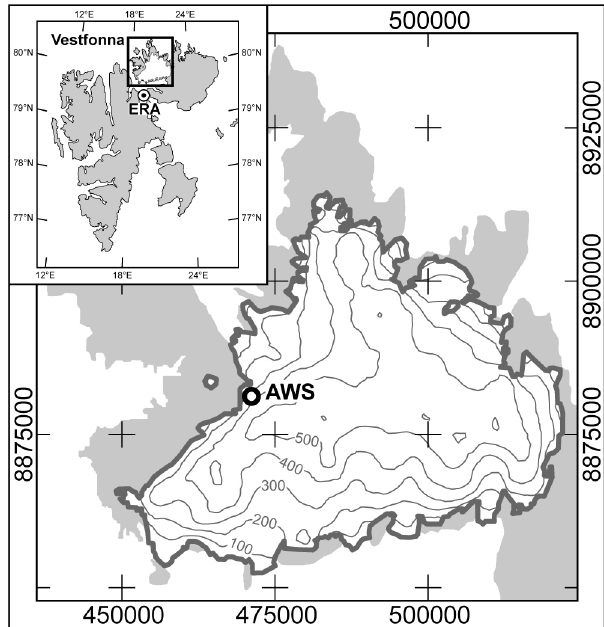
Fig. 1. Overview map of the study area. Coordinates refer to UTM (Universal Transverse Mercator) zone 34N. Contour spacing on the ice cap is 100m starting at sea level. The circle (AWS) marks the location of the automatic weather station. The inset on the up- per left shows the location of Vestfonna ice cap in the Svalbard Archipelago. The circle (ERA) marks the location of the ERA- Interim grid